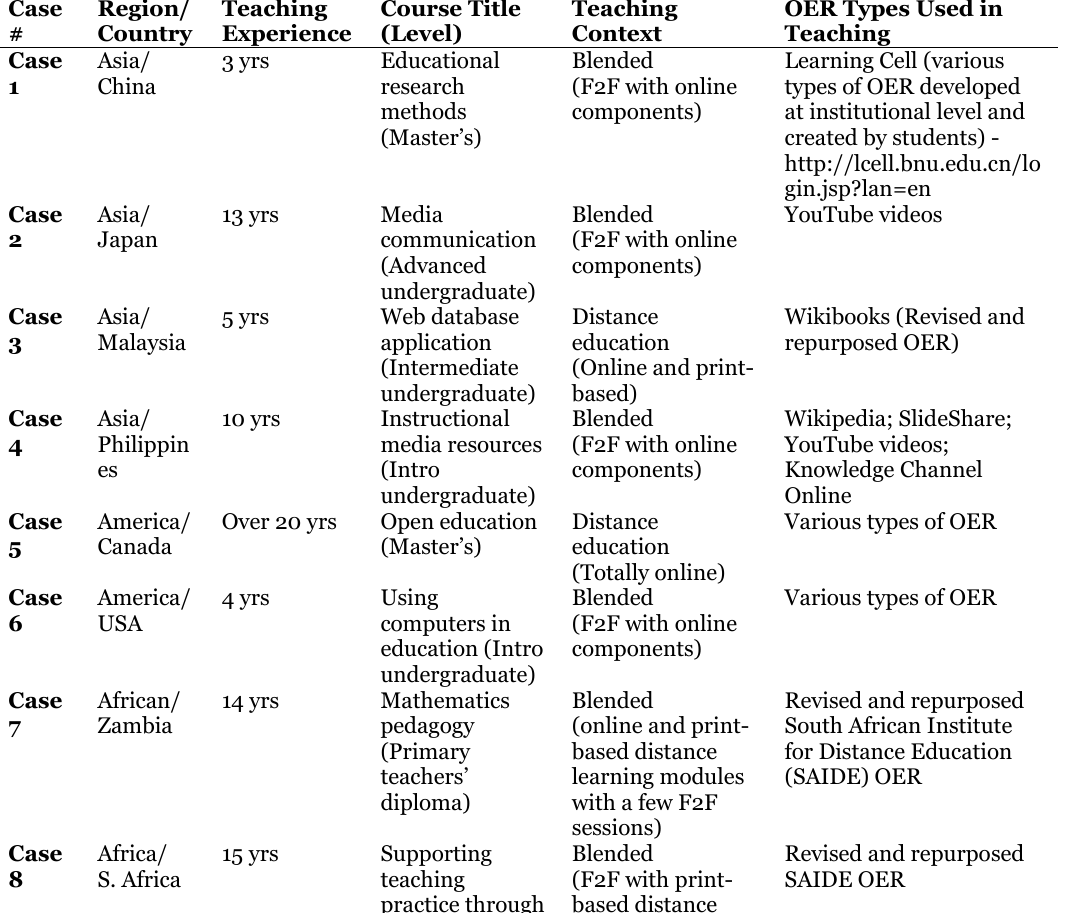
Overview of the 10 Cases Included in the